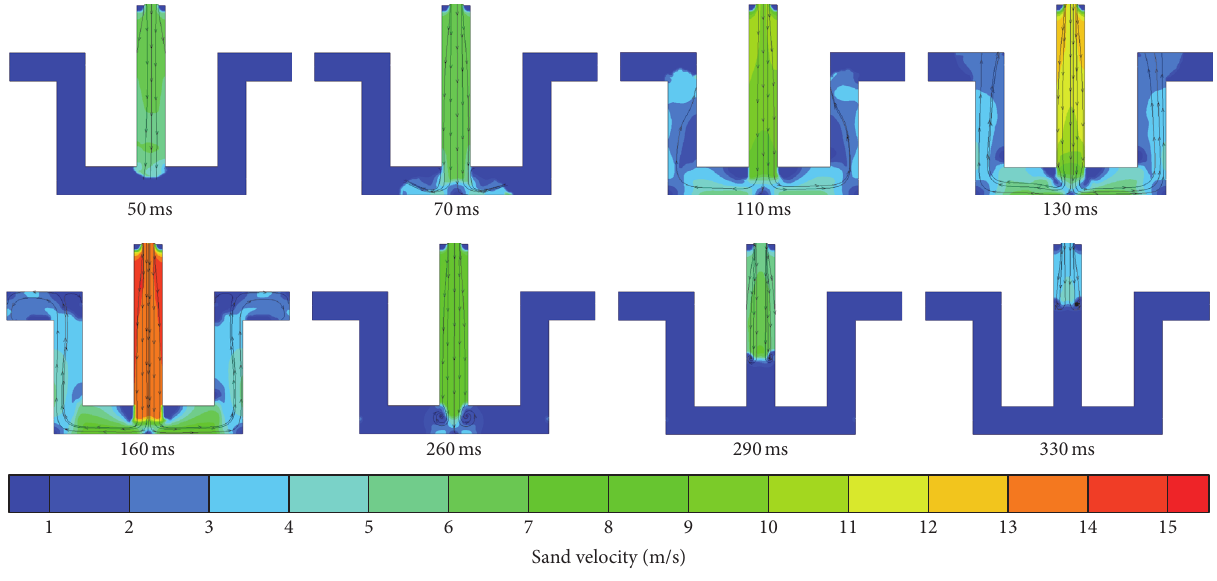
Figure 6: Evolution maps of sand velocity and streamlines in the core box.